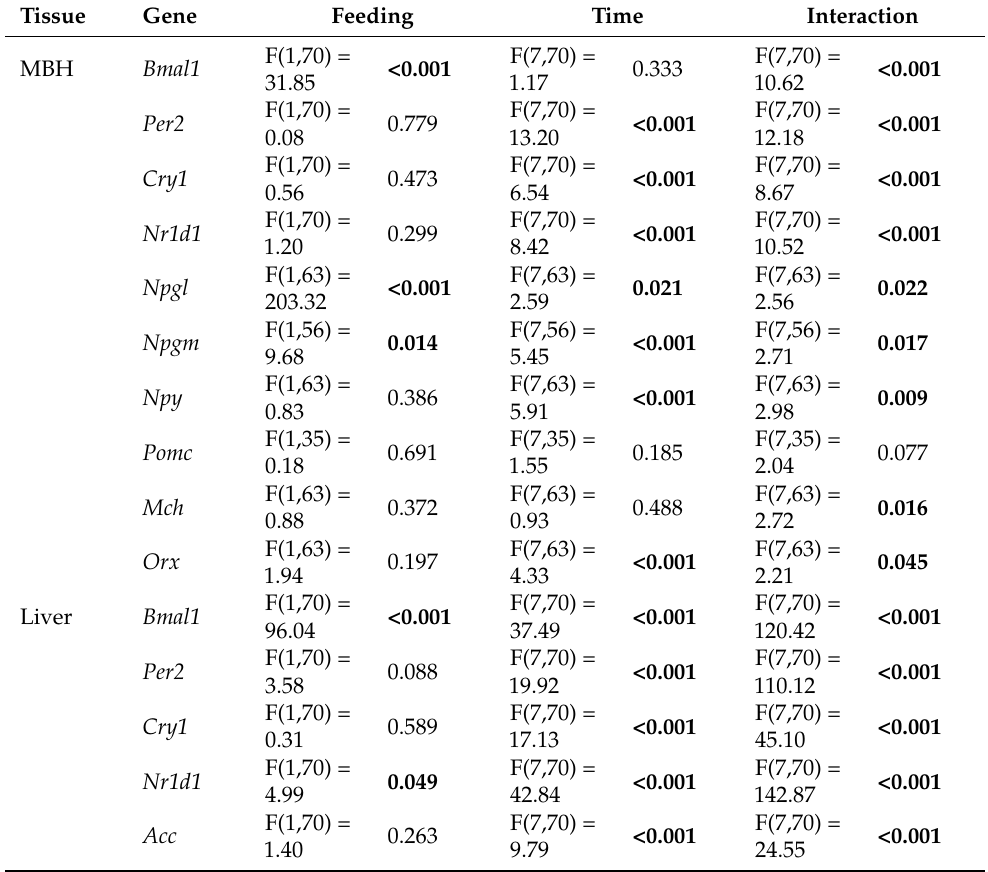
Table 3. Results of two-way ANOVA analyses on mRNA expression. Bold font indicates statisti- cal